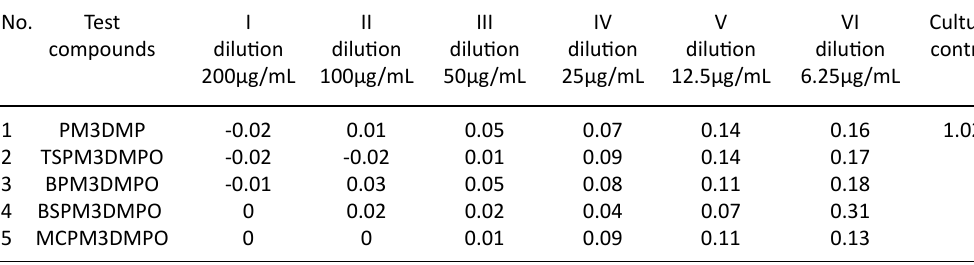
Table 10. MIC of Piperidines against E. coli a t 600 nm